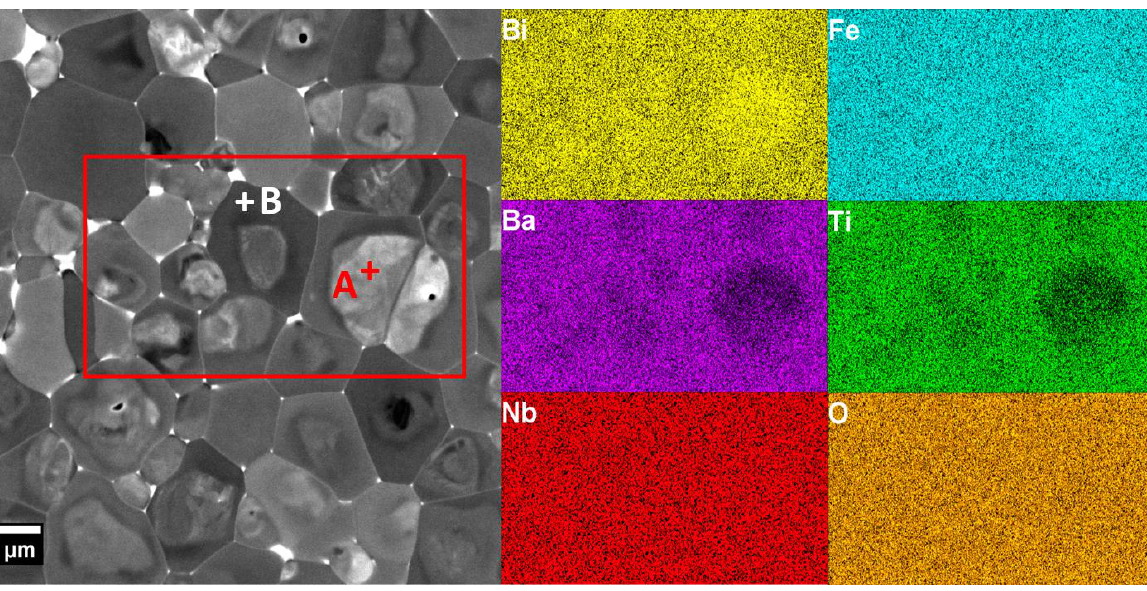
Figure 3. Back-scattered (BSE) SEM image and elemental mapping of the 0.7BF – 0.3BT – 4Nb ceramic. The red rectangular area defines the region used for micro-chemical mapping. Table 2. EDS point analysis (atomic %) of selected core (A) and shell (B) regions of the 0.7BF – 0.3BT – 4Nb ceramic shown in Figure 3.